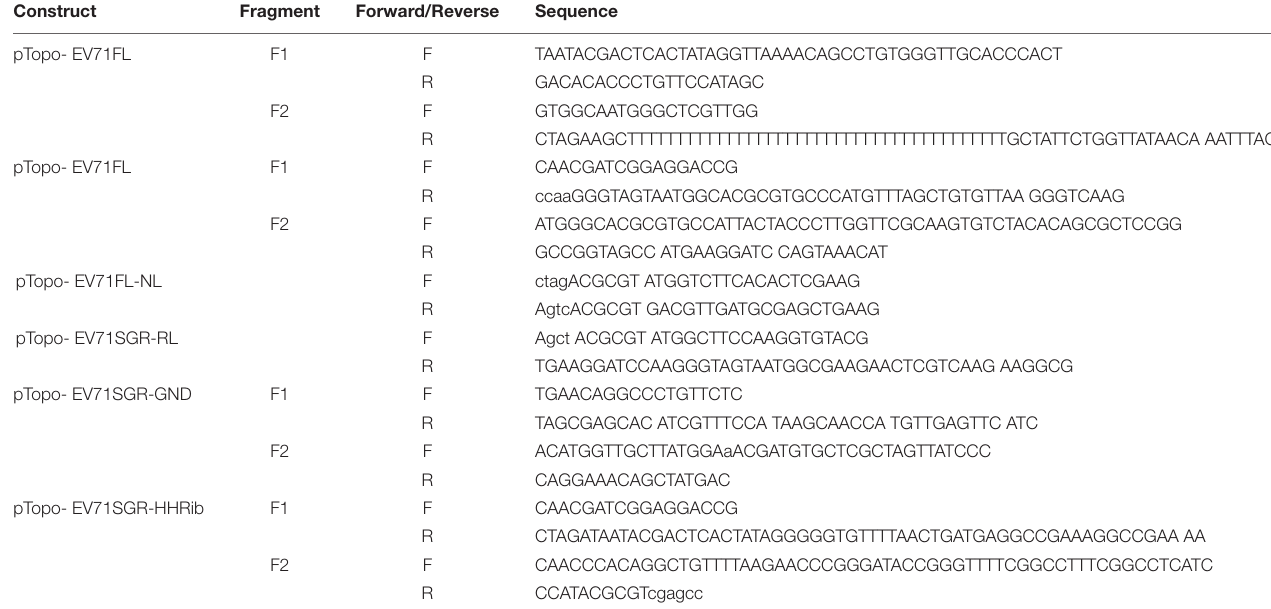
TABLE 1 | Primers used for DNA construct preparation.